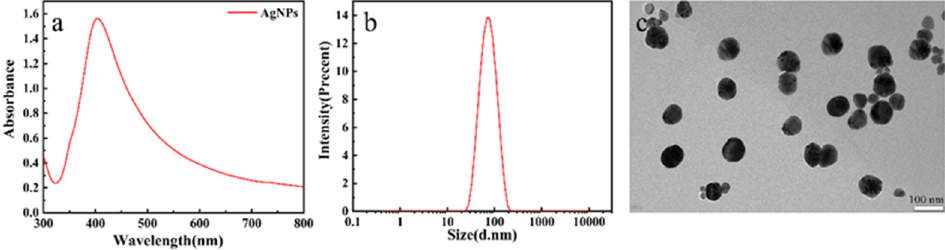
Figure 1. ( a ) UV–vis absorption spectrum of silver nanoparticles. ( b ) The particle size distribution of the silver colloid. ( c ) The TEM images of silver nanoparticles.